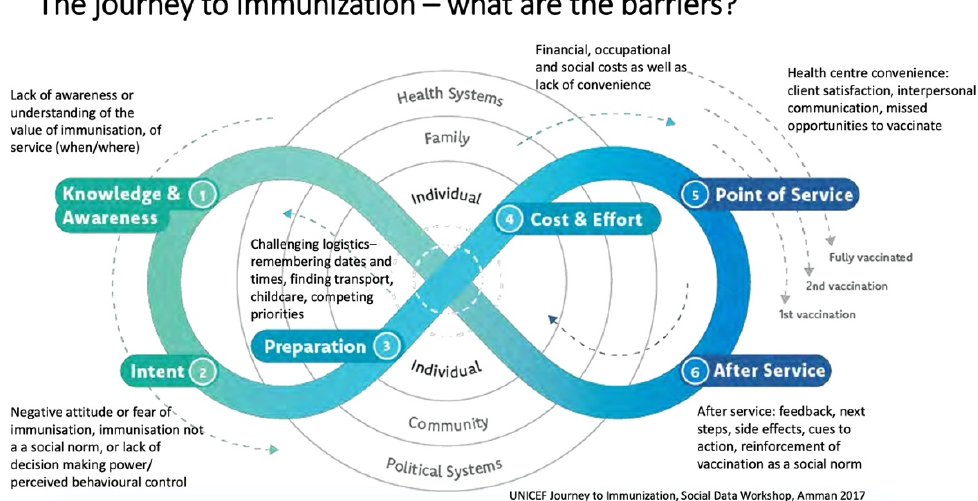
Figure 3. Journey to Immunization–UNICEF (2017) [19].